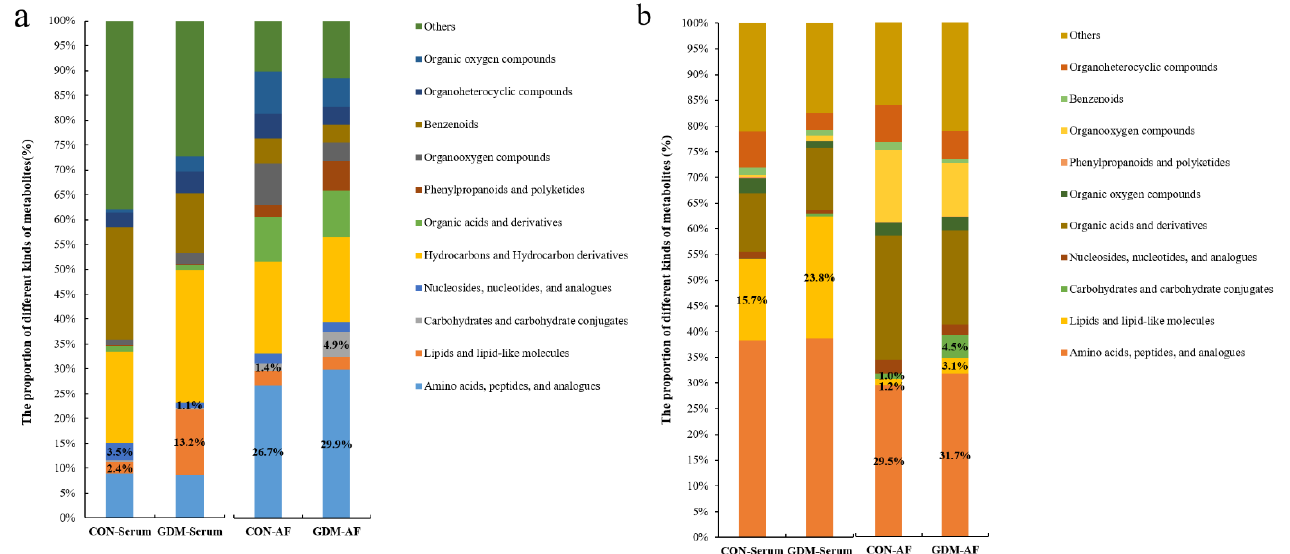
Figure 2. The proportion of different kinds of metabolites detected in serum and AF samples in CON and GDM. ( a ) The proportion of different kinds of metabolites only found in serum or AF samples. ( b ) The proportion of different kinds of common metabolites shared by serum and AF samples. CON-serum: serum samples in CON group; GDM-serum: serum samples in GDM group; CON-AF: AF samples in CON group; GDM-AF: AF samples in GDM group; AF: amniotic fluid.